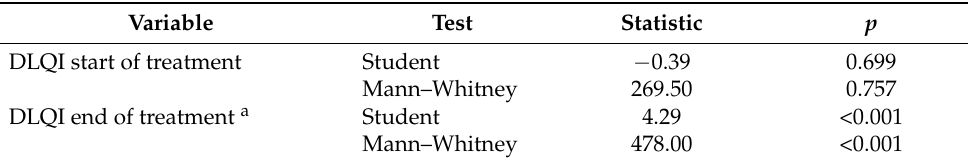
Table 5. Comparison of quality of life levels between groups.